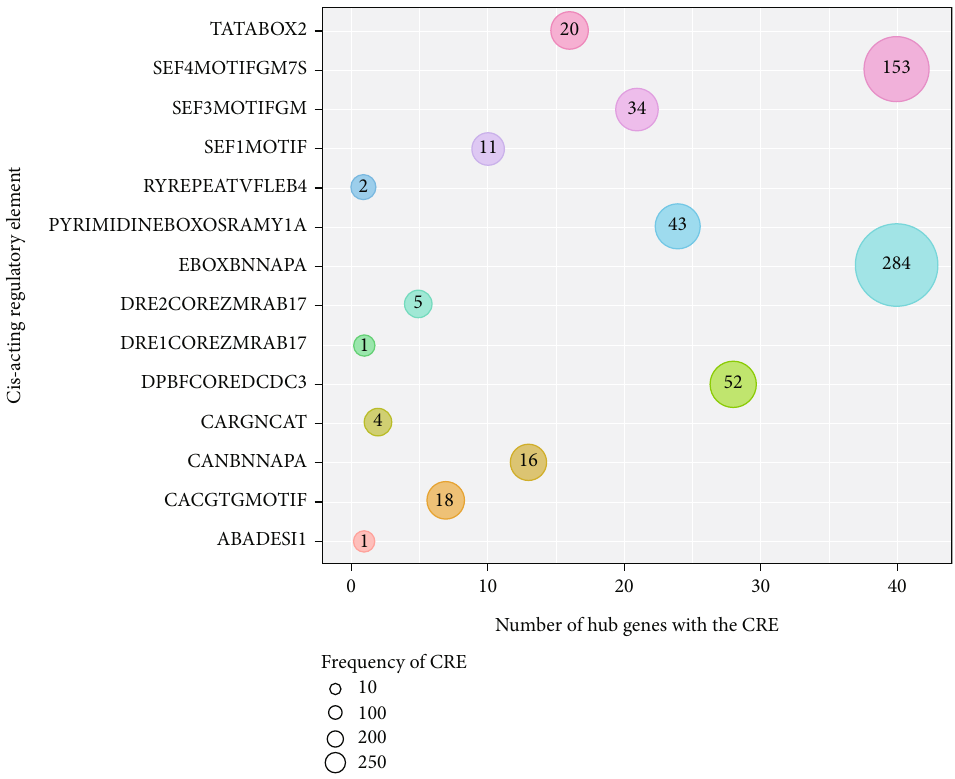
Figure 9: The distribution of several important plant CREs present in the promoter regions of functionally uncharacterized hub genes. The number of hub genes that contain the relevant CRE in their promoter region is indicated by the x -axis. The size of the circle depicts the occurrence of the CREs within the promoter regions of the hub genes (as indicated within the